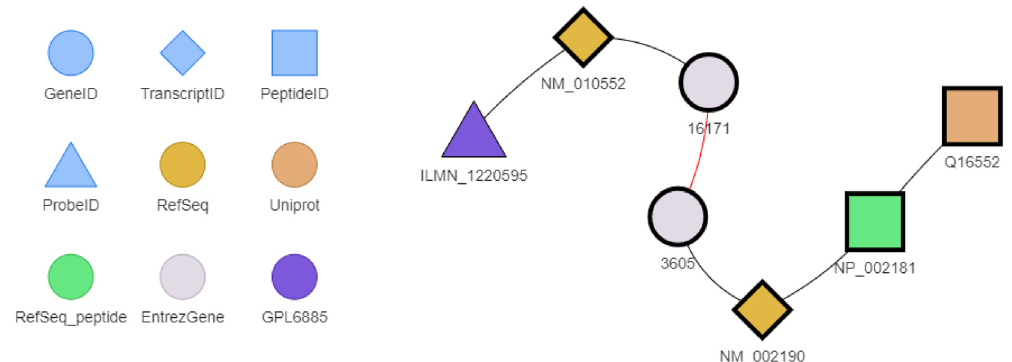
Figure 6. BED conversion shortest path between the ILMN_1220595 probe identifier targeting a transcript of the mouse Il17a gene and the Uniprot Q16552 identifier of the human IL17 protein. The legend is shown to the left of the figure. The red edge represents the is_homolog_of relationship. BEID surrounded in bold correspond to preferred identifiers. This graph has been drawn with the exploreConvPath function.